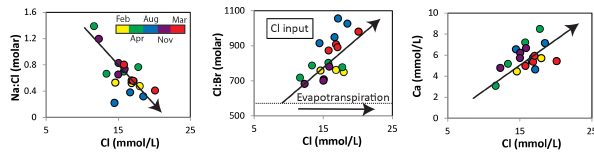
Figure 7. Trends in major ion chemistry at Kelly Creek indicating Cl inputs during increased rainfall.